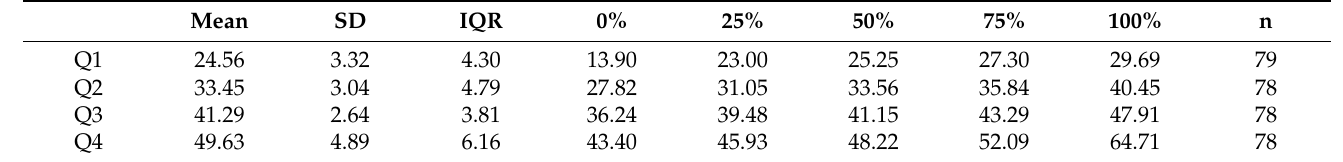
Table 8. Percentage elderly women. Sources: own elaboration based on data from the Galician Institute of Statistics (IGE), Municipal Register of Inhabitants, the year 2021.